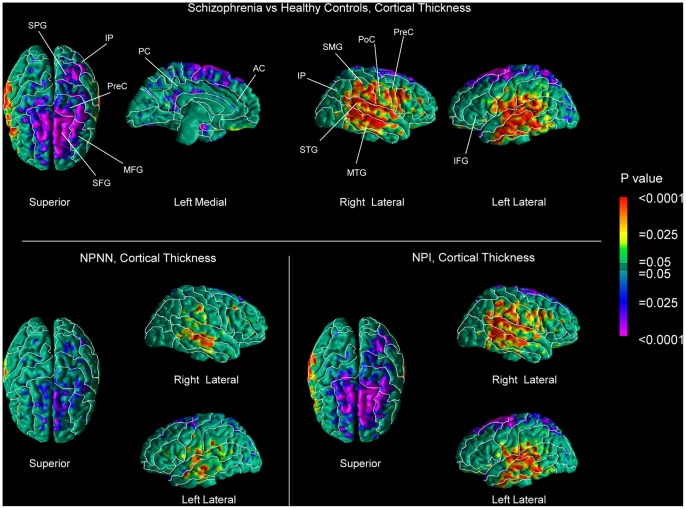
Maps of Group Differences in Cortical Thickness in Persons with Schizophrenia Compared with Healthy Controls.Statistical effects are color-encoded as in Fig. 1. Cortical thickness was rescaled for whole brain size. Results are GRF-corrected. Patients were divided in two subgroups: neuropsychologically near normal patients (NPNN; n = 21) (Lower Left) and neuropsychologically impaired (NPI; n = 50) (Lower Right) patients based on performance scores on the SPT. AC, anterior cingulate; IP, inferior parietal lobule; MFG, middle frontal gyrus; MTG, middle temporal gyrus; PC posterior cingulate; PoC, postcentral gyrus; PreC, precentral gyrus; SFG, superior frontal gyrus; SMG, supramarginal gyrus; SPG, superior parietal gyrus; STG, superior temporal gyrus. Other labels are the same as in Fig. 1. (Upper) Entire patient group compared with healthy controls. (Lower Left) NPNN subgroup (n = 21) compared with healthy controls (n = 57). (Lower Right) NPI subgroup (n = 50) compared with healthy controls. Patients exhibited greater cortical thickness in the perisylvian cortices in both hemispheres, as well as thinner cortices in the superior frontal, superior parietal and cingulate gyri. We did not observe any differences in the degree of cortical thickness when we compared neuropsychological groups directly to each other. These findings were preserved in unscaled data.